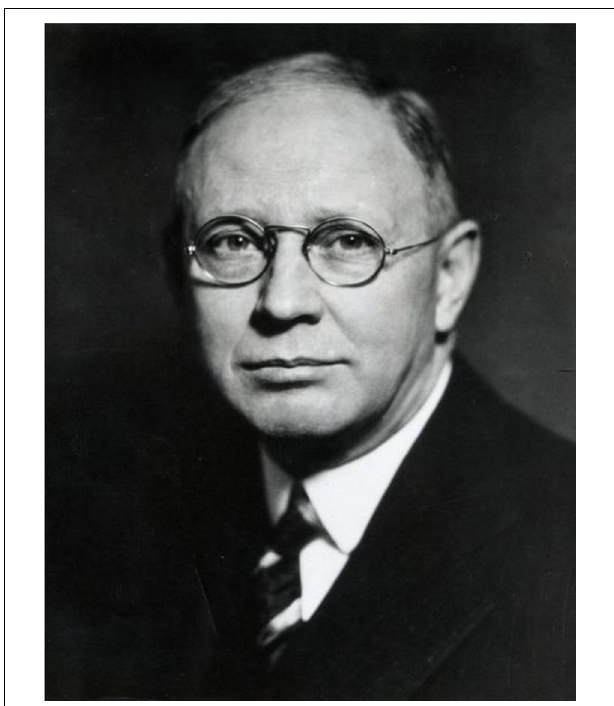
FIGURE 2 | Clark Leonard Hull (1884–1952).